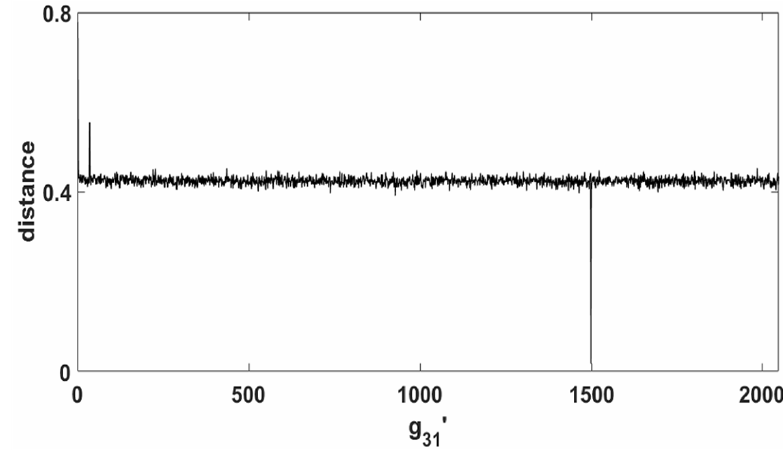
Figure 2. Harmonic Mean Distance using four random variables A , B , C , D